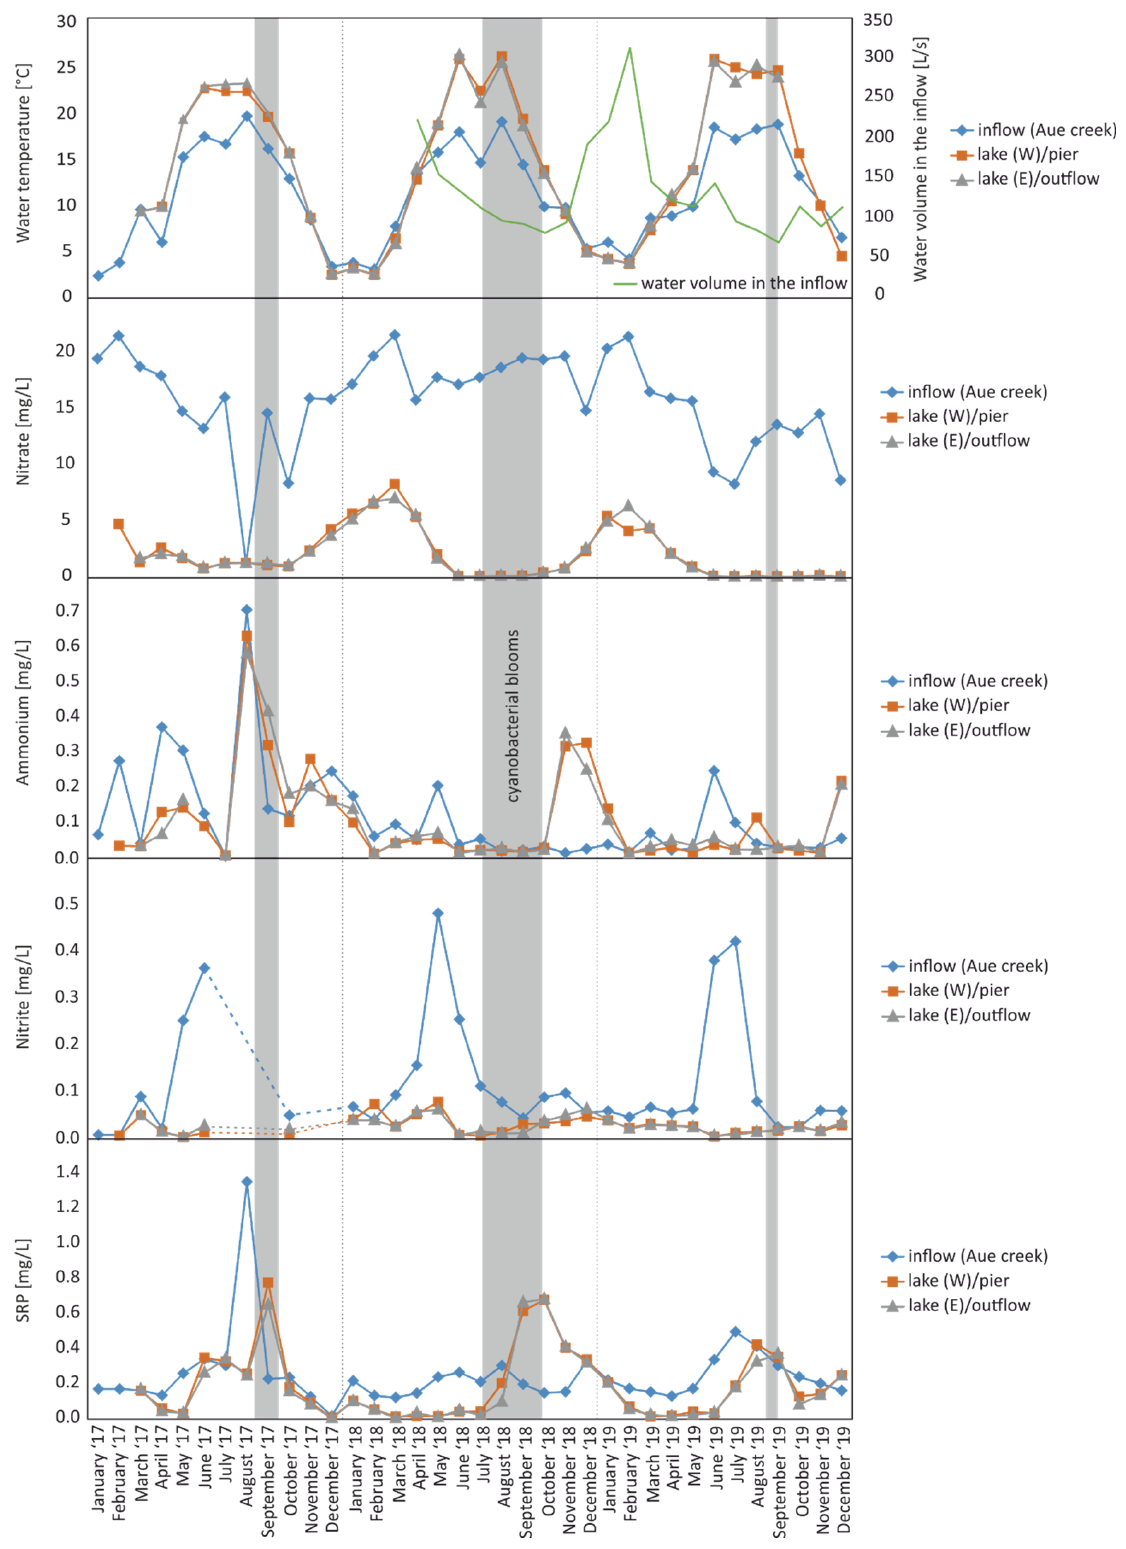
Figure 2. Seasonal variability (2017–2019) of temperatures and nutrient concentrations for the inflow (Aue creek), western (pier), and eastern (near the outflow) parts of Lake Seeburg. The water volume in the inflow, measured between April 2018 and December 2019, is given in the top figure (green line). Episodes of cyanobacterial blooms are shaded in grey. For detailed concentration data, see Table S2. Dotted lines, no data available.